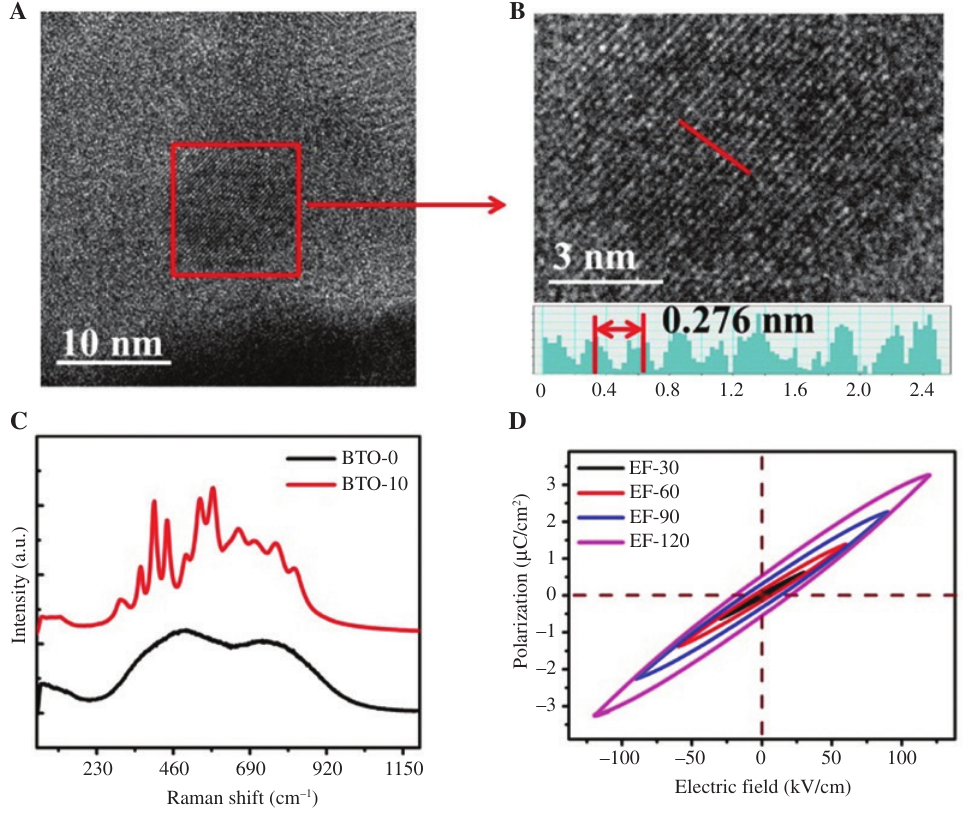
Figure 2: Crystal’s morphology and ferroelectric properties of the ferroelectric composite. (A) The HR-TEM image of BTO-10. (B) The HR-TEM image of the nanocrystal and lattice. (C) Raman spectra of BTO-0 and BTO-10 samples. (D) Ferroelectric hysteresis P-E loop of EF-i (i = 0, 30, 60, 90 and